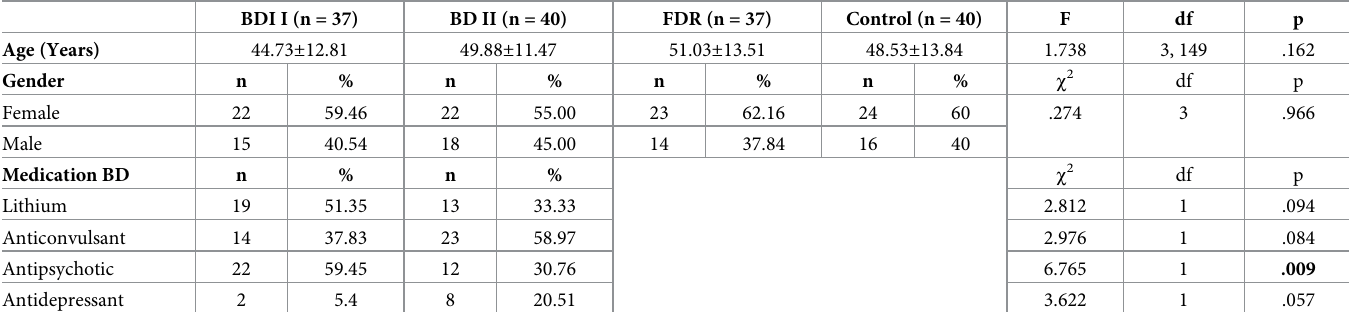
Table 1. Demographic and clinical characteristics of the